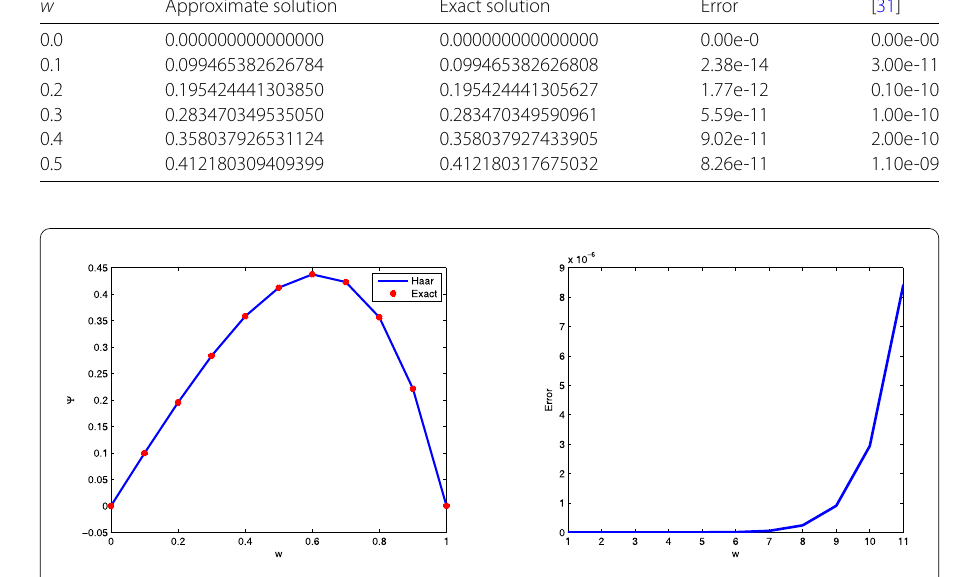
Table 3 Comparison of approximate and exact solution and absolute error of Example 5.3 when J = 4 w Approximate solution Exact solution Error [31] 0.0 0.000000000000000